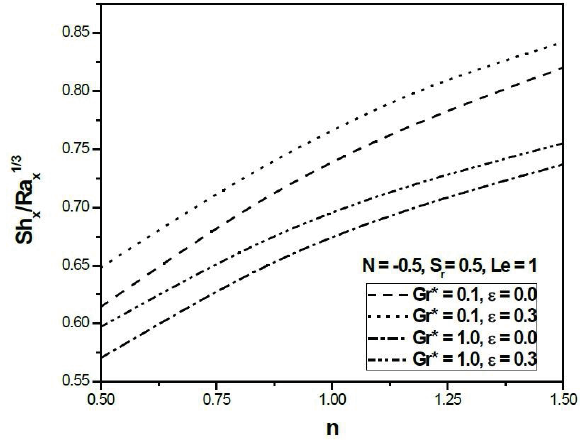
Fig. 8: Variation of heat transfer coefficient against n (Opposing Buoyancy.